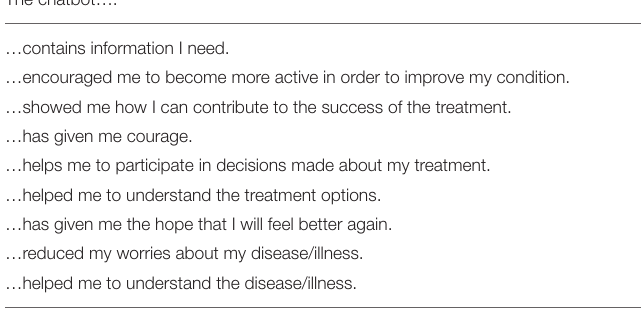
TABLE 5 | Results of the USE questionnaire. The chatbot….